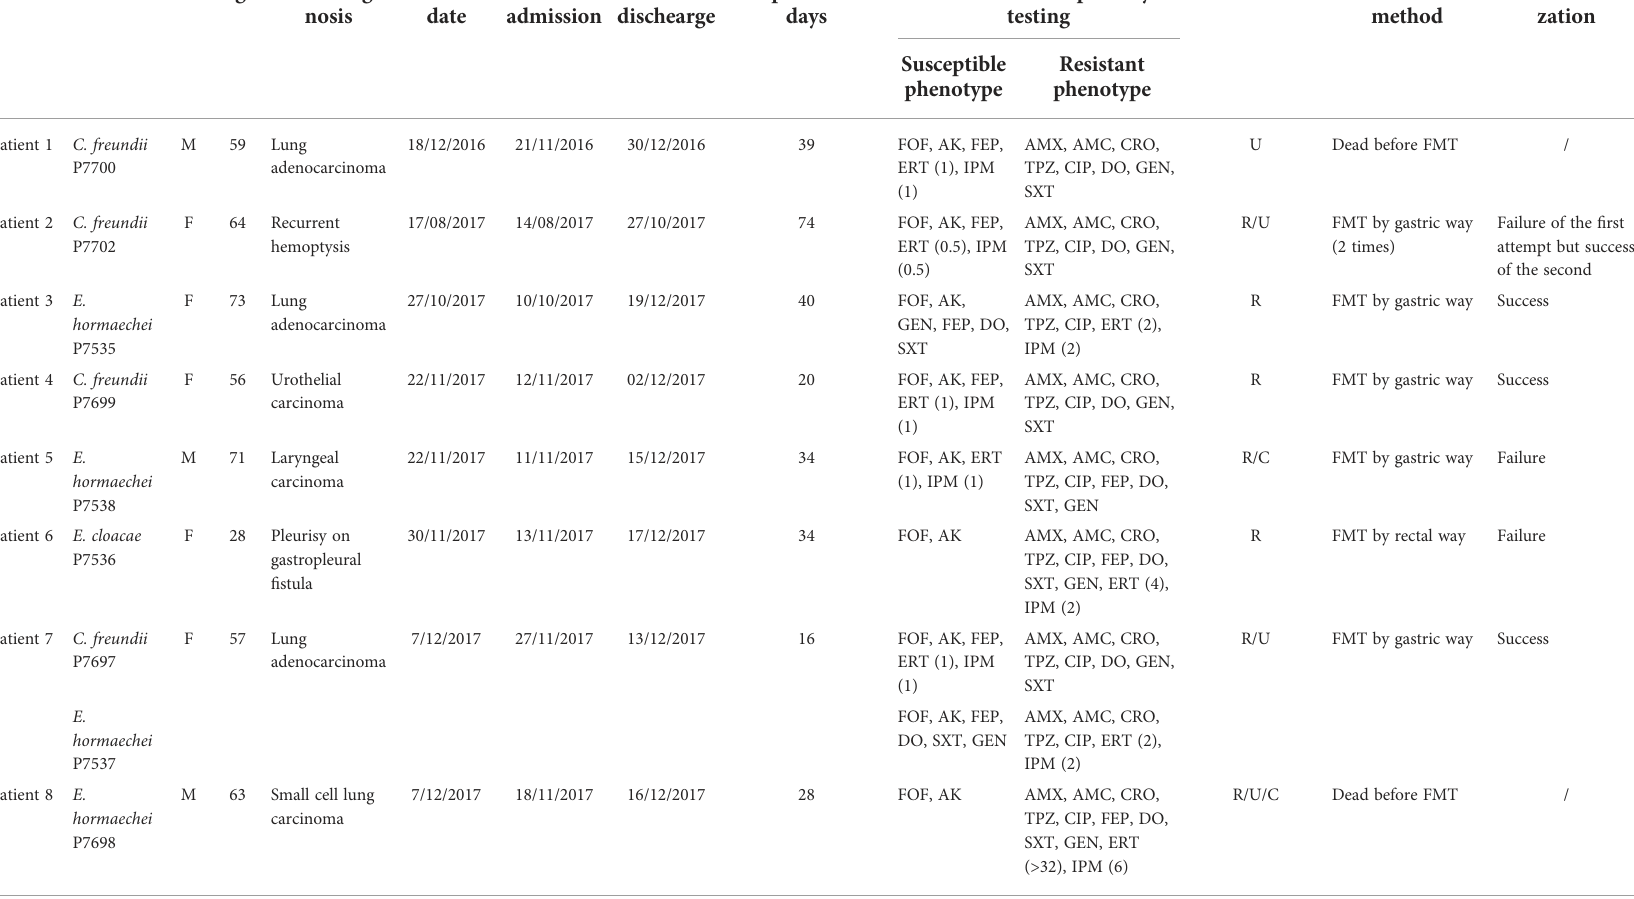
TABLE 1 Clinical information on patients with OXA-48